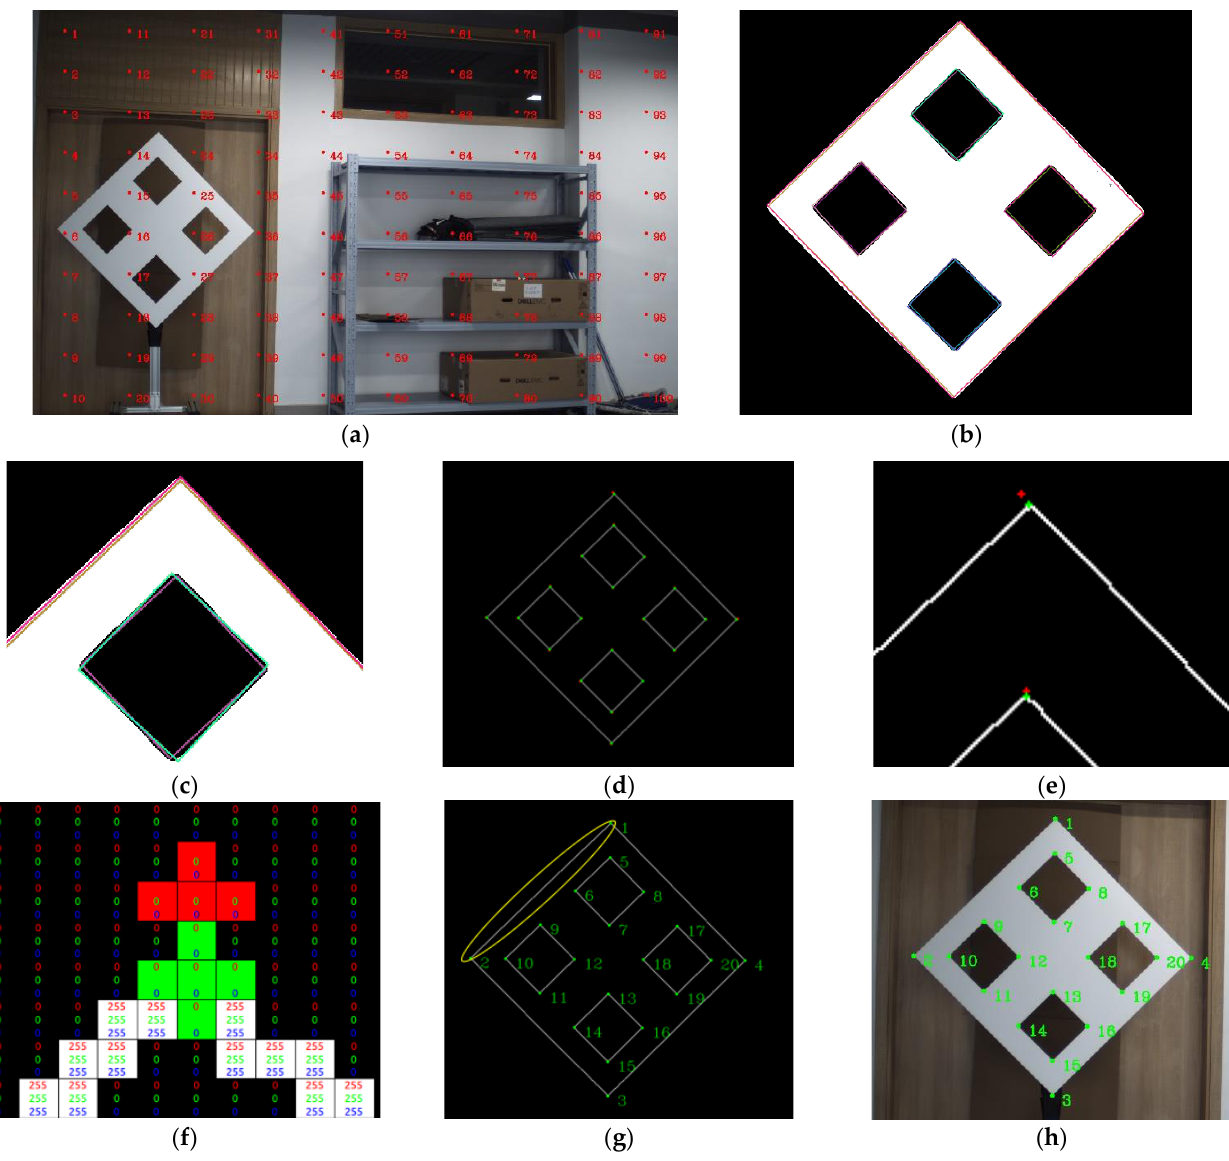
Figure 7. Automatic extraction process of 2D feature points. ( a ) shows the original image and seed points in each of cells, ( b ) presents the rectangle detected after the RGA by one seed point, ( c ) is the local graph of ( b ), it can be clearly seen that multiple rectangles are detected at the same location, green points in ( d ) illustrate refined corner points, red points illustrate roughly detected corner points, ( e , f ) are the partial diagram of ( d ), ( g ) is the detected and sorted corner points, the points in the yellow ellipse are used to fit 𝑙′ 𝑞 1 q 2 , and ( h ) shows the final corner points colored in the original image.